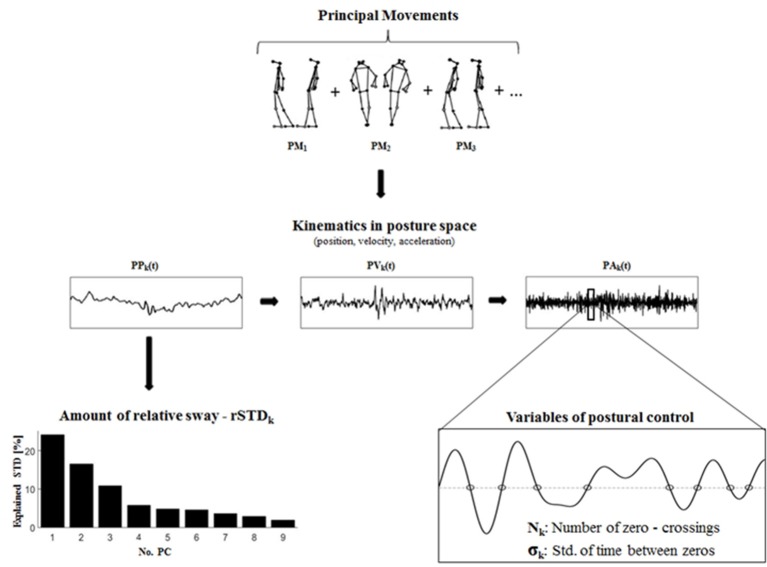
The computation of the variables rSTDk, Nk, and σk from results of the PCA.